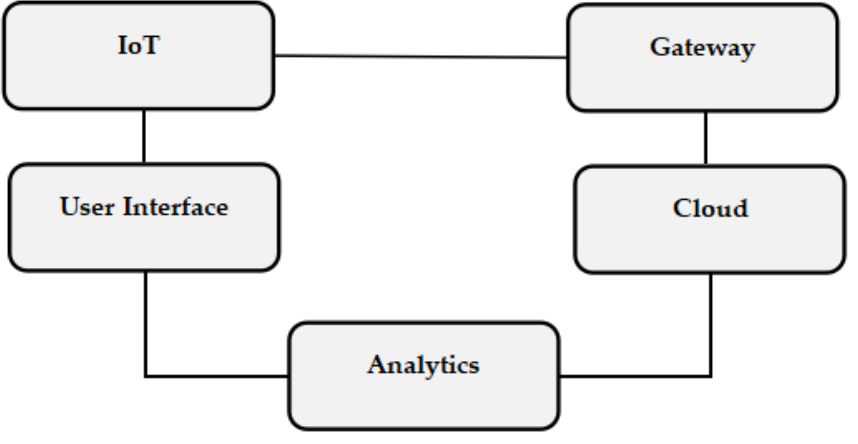
Figure 3. Essential components of IoT [32].